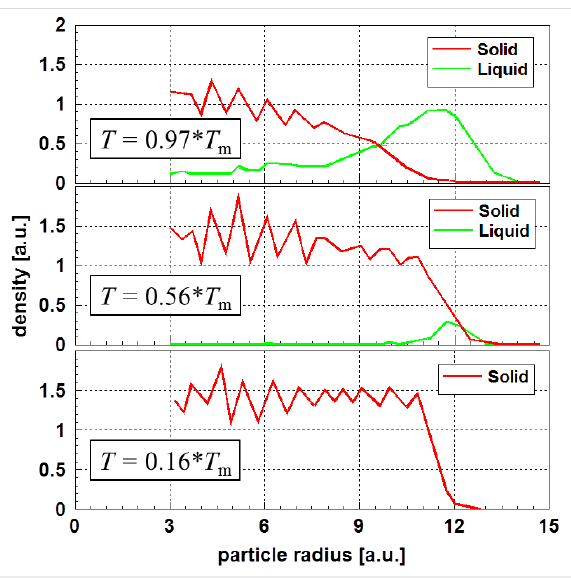
Figure 8: Radial profiles of the density for a fcc metal cluster consisting of 3302 atoms versus the particle radius [43]. One observes the formation of a noncrystalline layer at the surface, which is consid- ered liquid-like in the vicinity of the melting temperature of the particle, T = 0.62· T m ( T m – melting temperature of the bulk material).